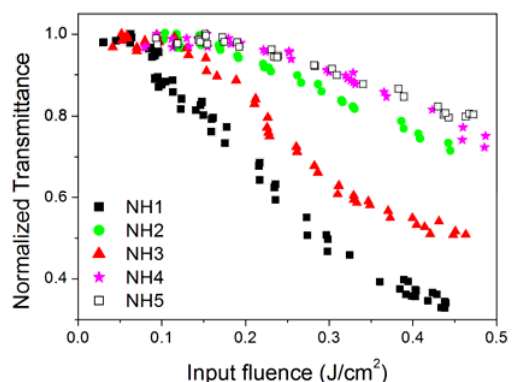
Figure 12. Comparison of OL performances at 532 nm and the concentration of 0.05 g / L as a function of the cluster size (see Table 2 for cluster dimensions).